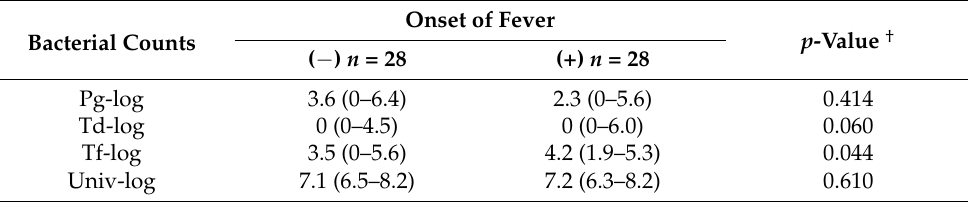
Table 2. Comparison of bacterial counts of periodontal pathogens with the onset of fever. Bacterial